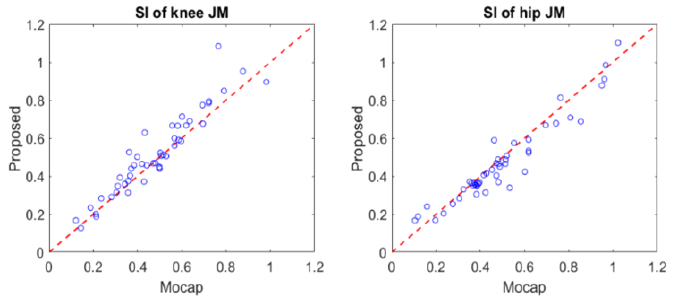
Figure 5. Comparison between the symmetric index (SI) estimated by the proposed method and measured by the motion capture system.